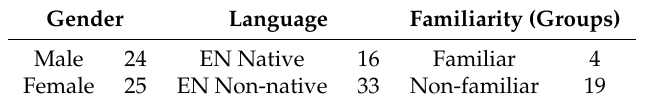
Table 1. Distribution of corpus participants per gender, language, and familiarity among group